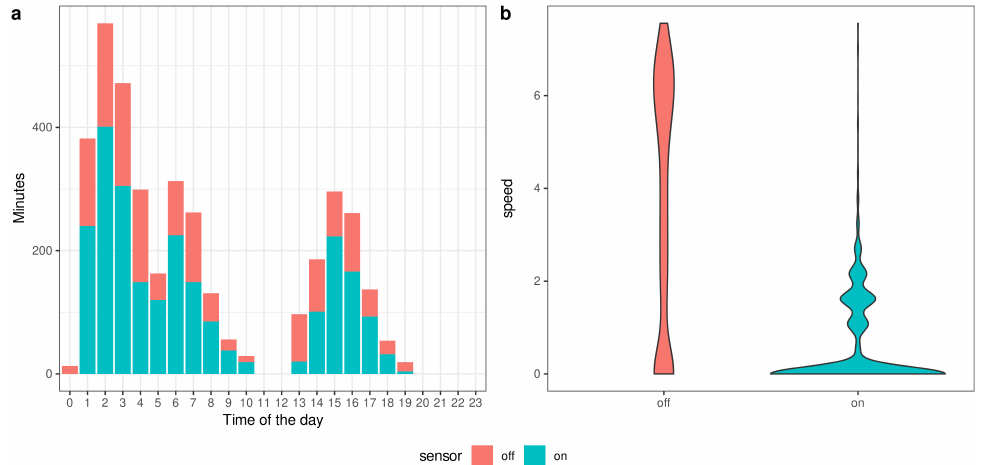
Figure 5. Fishing activity (minutes) over daytime, excluding steaming and in-port reports ( a ), and speed values by hauler activity ( b